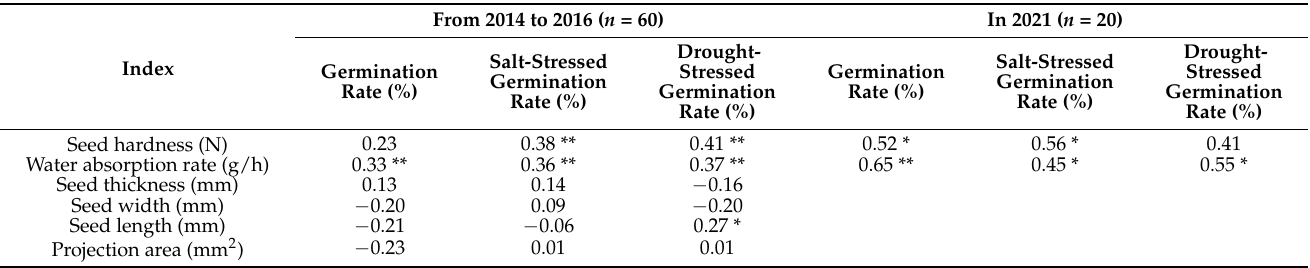
Table 3. Correlation analysis between seed vigor indicators and physical properties of rice cultivars collected from different years.